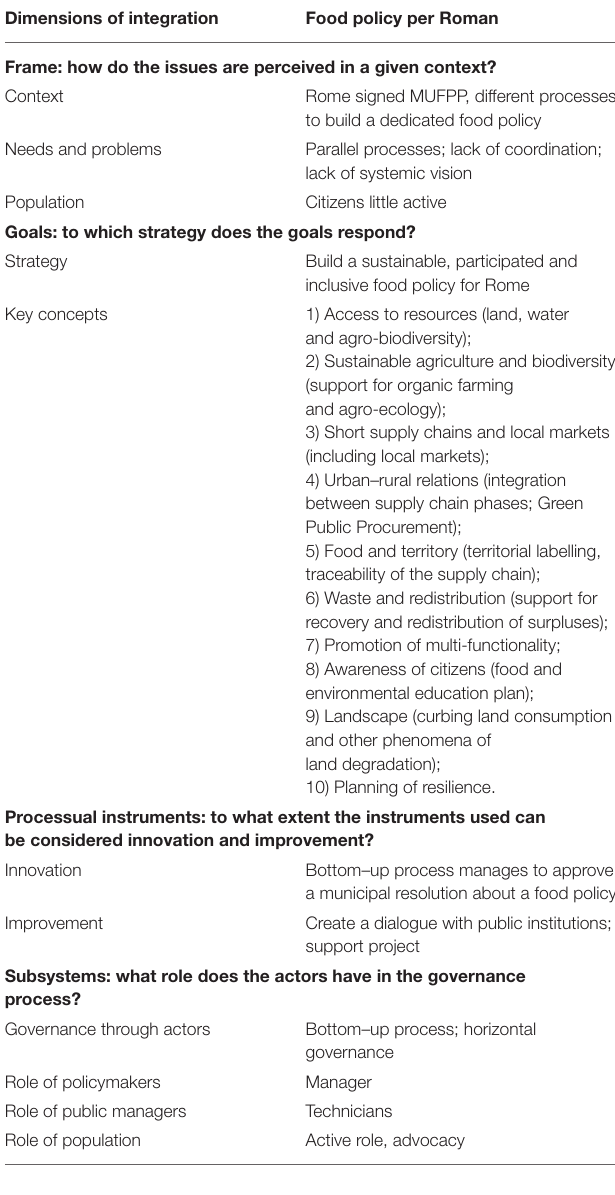
TABLE 6 | Summary of food policy for Rome process through framework (source: